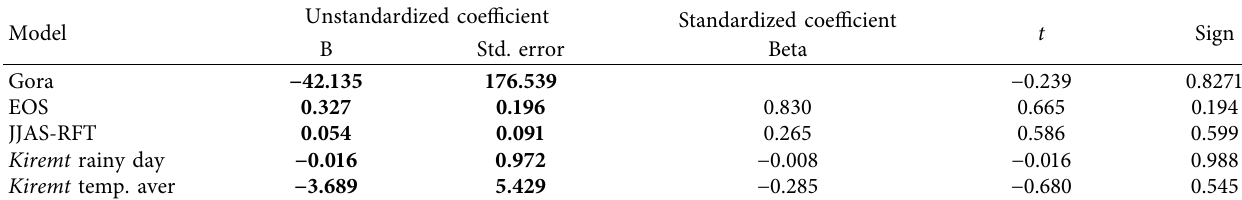
Table 8: Coefficient of regression analysis for rainfall and temperature at Welmera